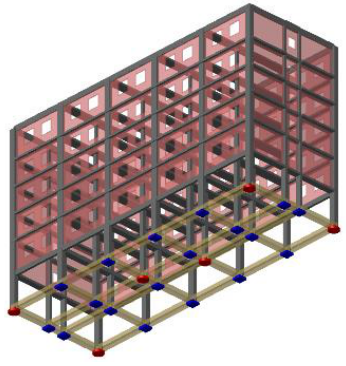
Figure 22. RP4 principal structure.